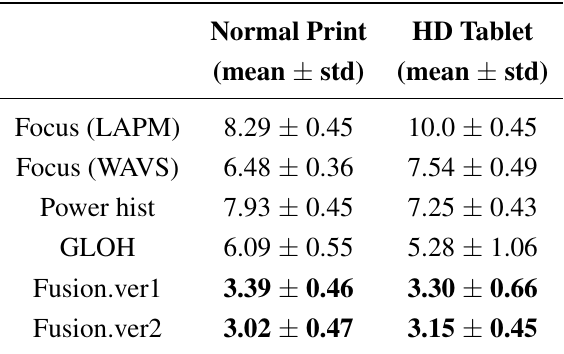
Table 4. HTERs (%) of experiments with the webcam